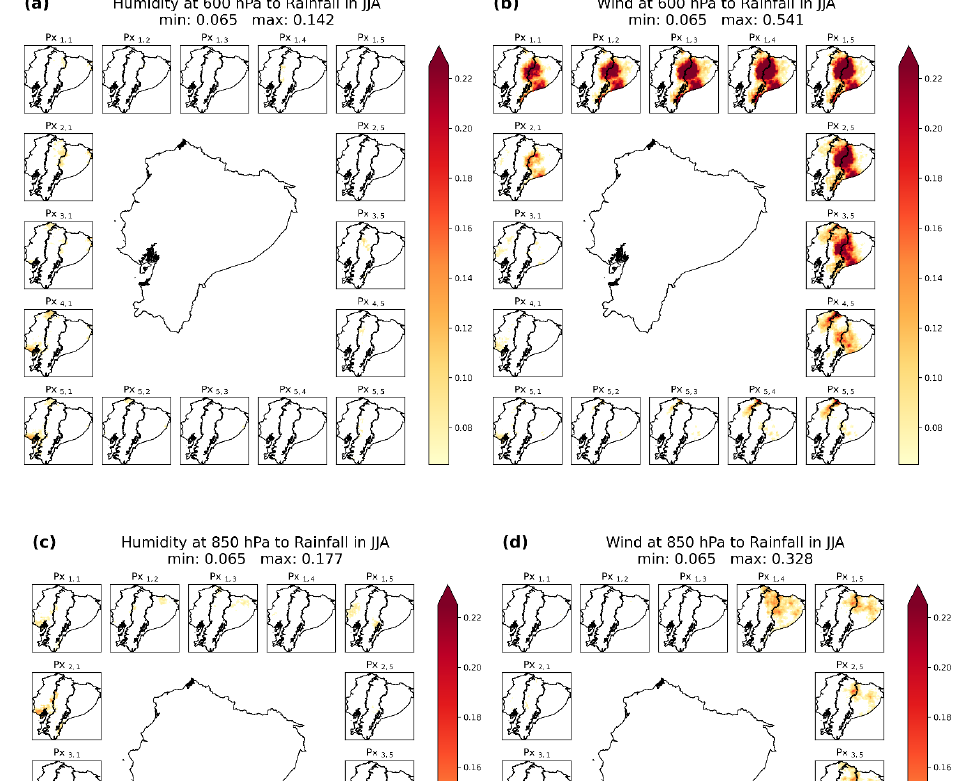
Figure 6. Spatial patterns of GC strength of connections ( p -value ≤ 0.01) between humidity and rainfall in DJF at ( a ) 600 hPa, ( c ) 850 hPa, and ( e ) 1000 hPa; and between wind and rainfall in DJF at ( b ) 600 hPa, ( d ) 850 hPa, and ( f ) 1000 hPa.